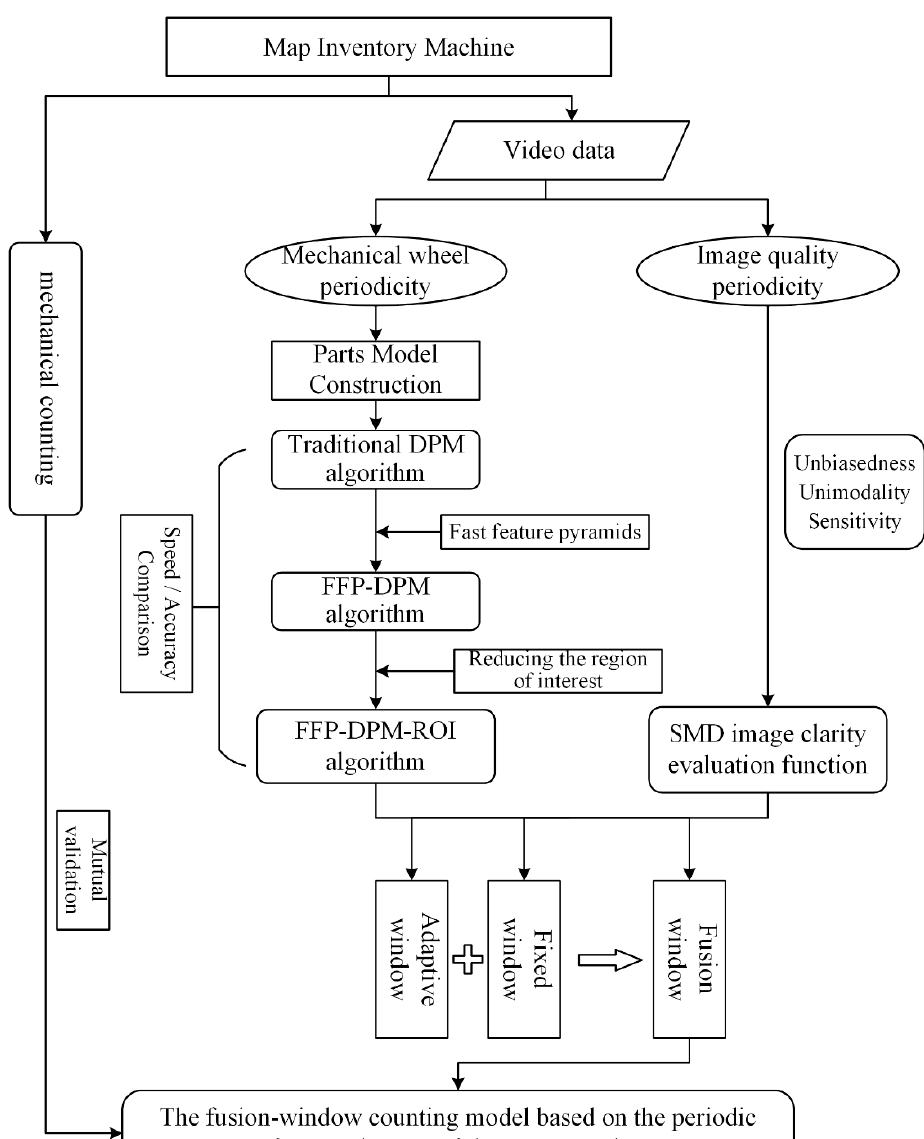
Figure 6. The flowchart of the